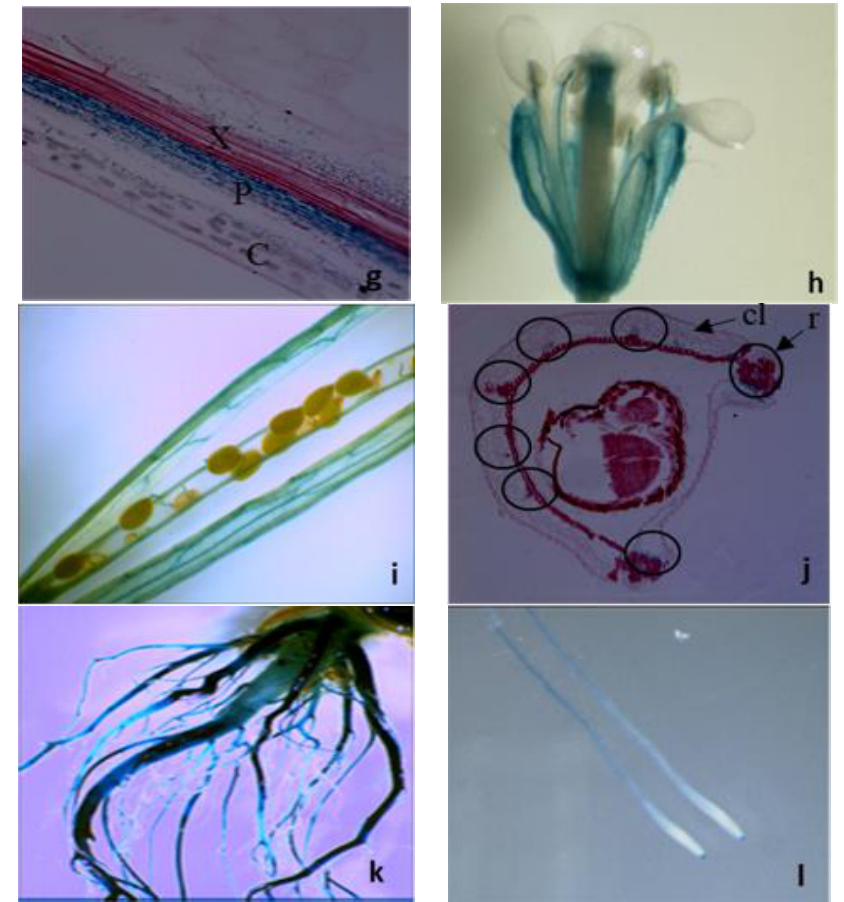
Figure 2. Organ- and tissue-specific expression analyses of the LAT5/PUT5. ( a )